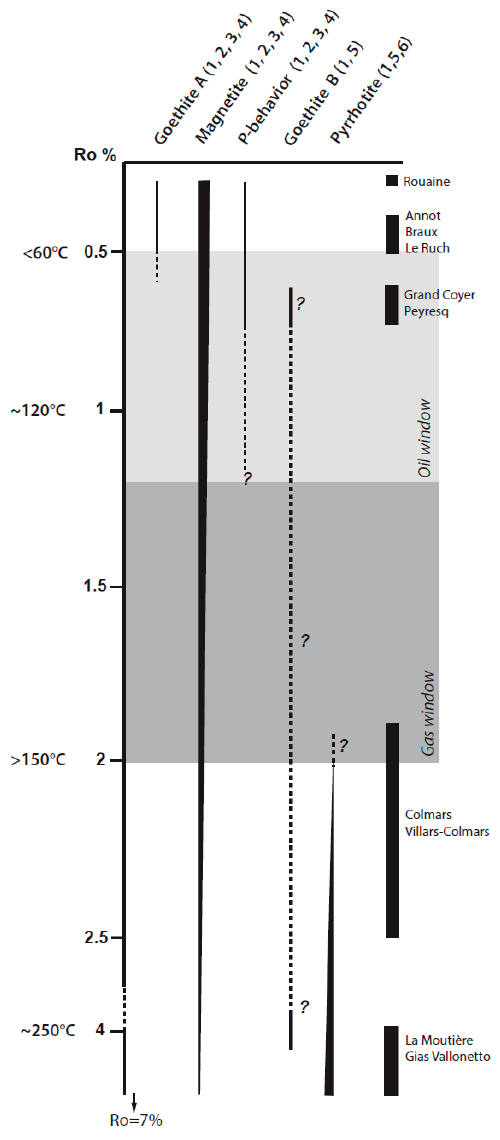
Figure 8. Global burial model for magnetic minerals in clay-rich rocks. The burial temperatures are deduced from the vitrinite reflectance data by using